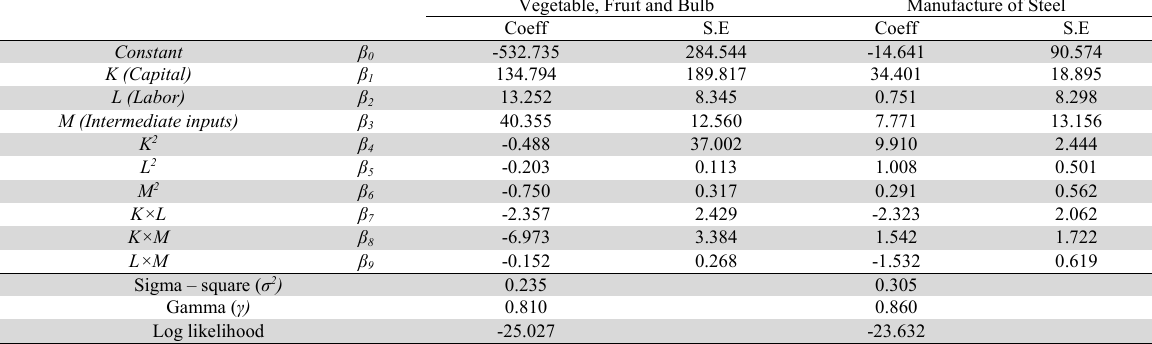
Vegetable, Fruit and